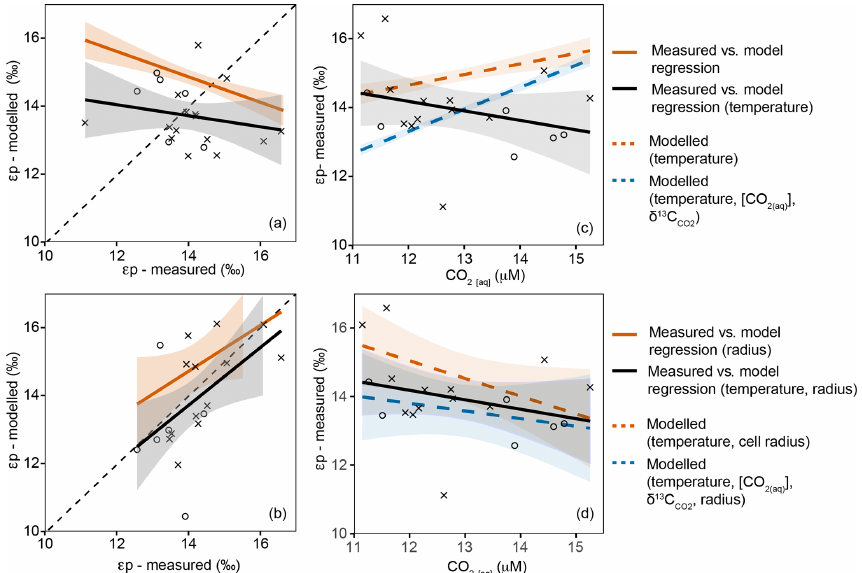
Figure 7. Variation in modelled and measured ε p in the upper 60m with changing [CO 2 ( aq ) ]. Black points and lines show measured ε p , circles represent SASW and crosses represent subtropical water masses. (a, c) The regressions for modelled and measured ε p ; (b, d) modelled and measured ε p against [CO 2 ( aq ) ]. Panels (a) and (b) explore the predicted ε p using temperature, [CO 2 ( aq ) ] and δ 13 C CO explore the predicted ε p using temperature, [CO 2 ( aq ) ], δ 13 C CO